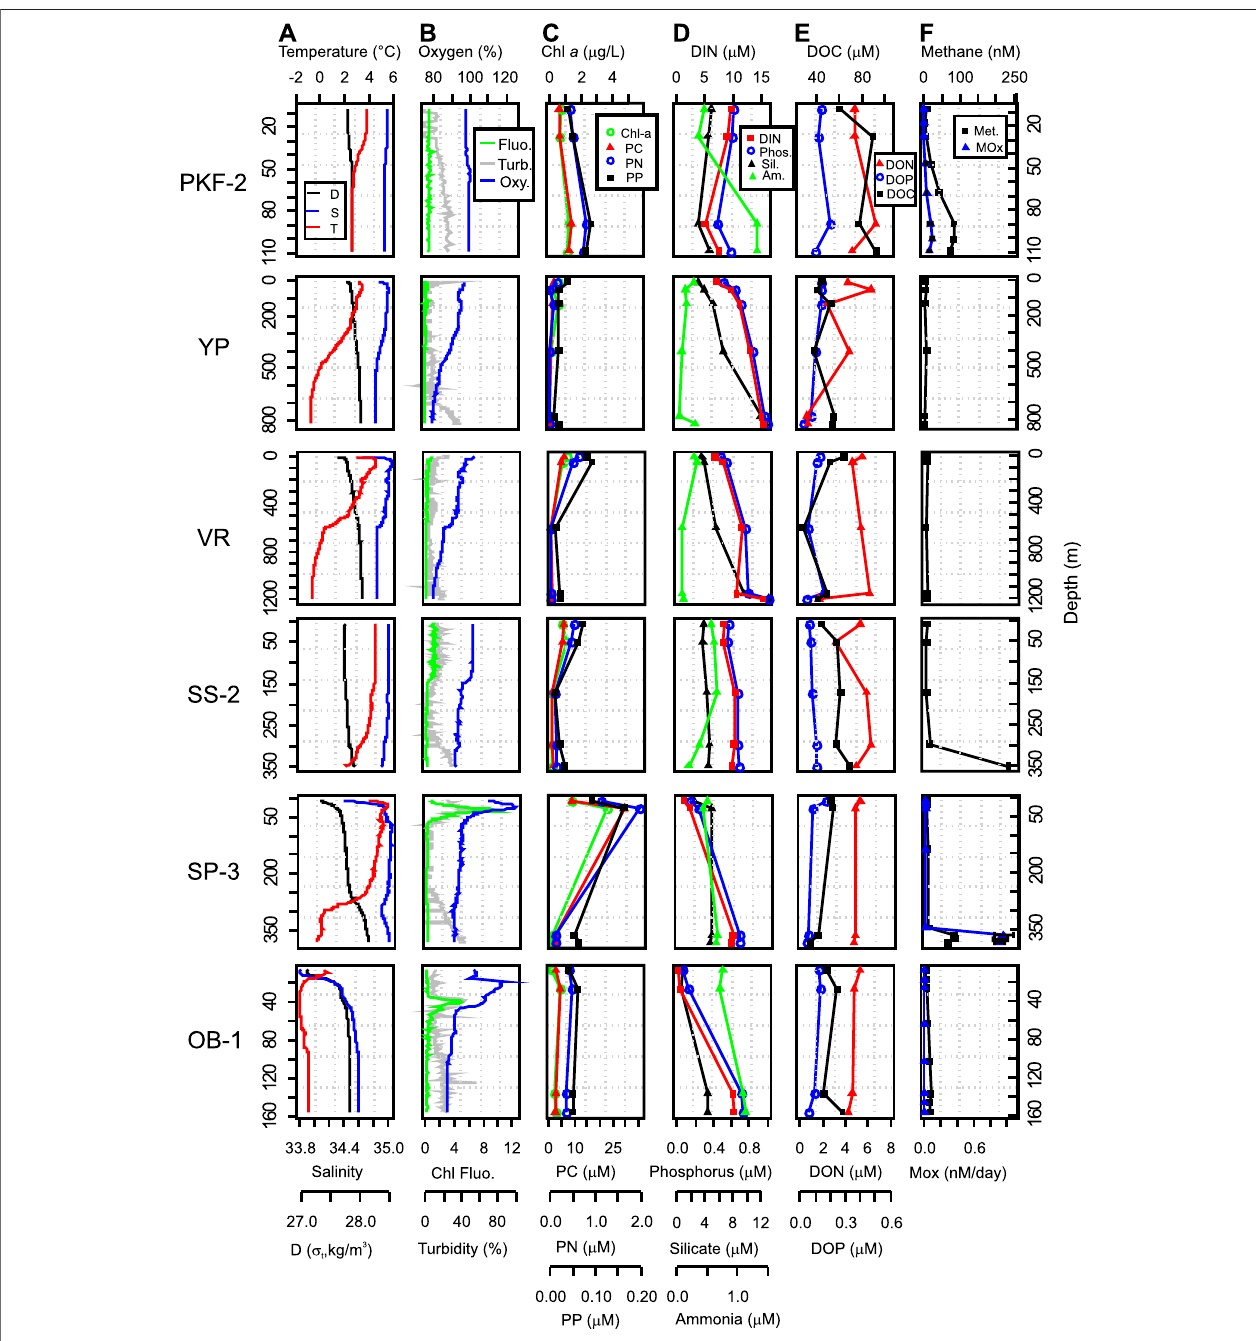
FIGURE 3 | Depth pro fi les of selected stations. Each row of pro fi les represents the typical features from regions listed in Table 1 . Abbreviations are PC, PN, PP, particulate carbon, nitrogen and phosphorus; DOC, DON, DOP, dissolved organic carbon, nitrogen and phosphorus; DIN, dissolved inorganic nitrogen; D, density; T, temperature; S, salinity; Chl Fluo., Chlorophyll fl uorescence; Mox, methane oxidation.